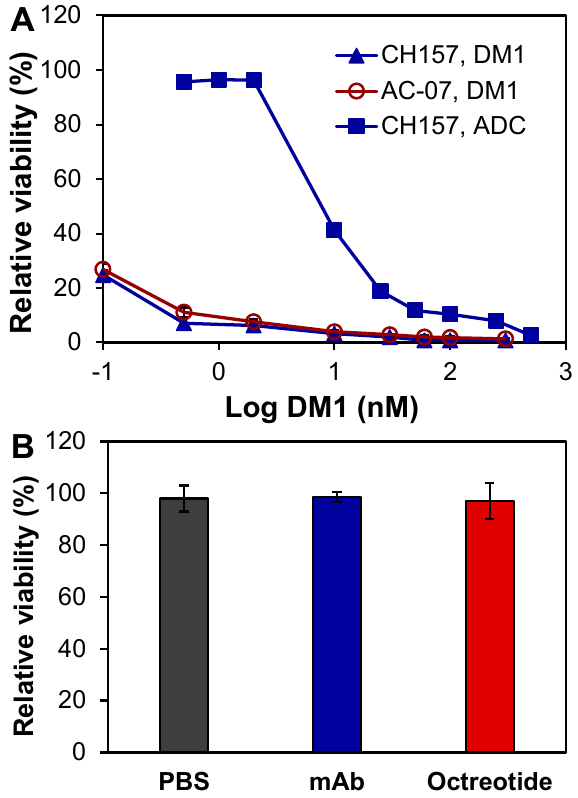
Figure 3. In vitro anti-meningioma cytotoxicity. ( A ) Evaluation of free drug and ADC using CH-157-MN and AC07 cells. ( B ) Effect of PBS, mAb, and octreotide (controls) in CH-157-MN cells. Data represent mean ± SEM, n = 3.